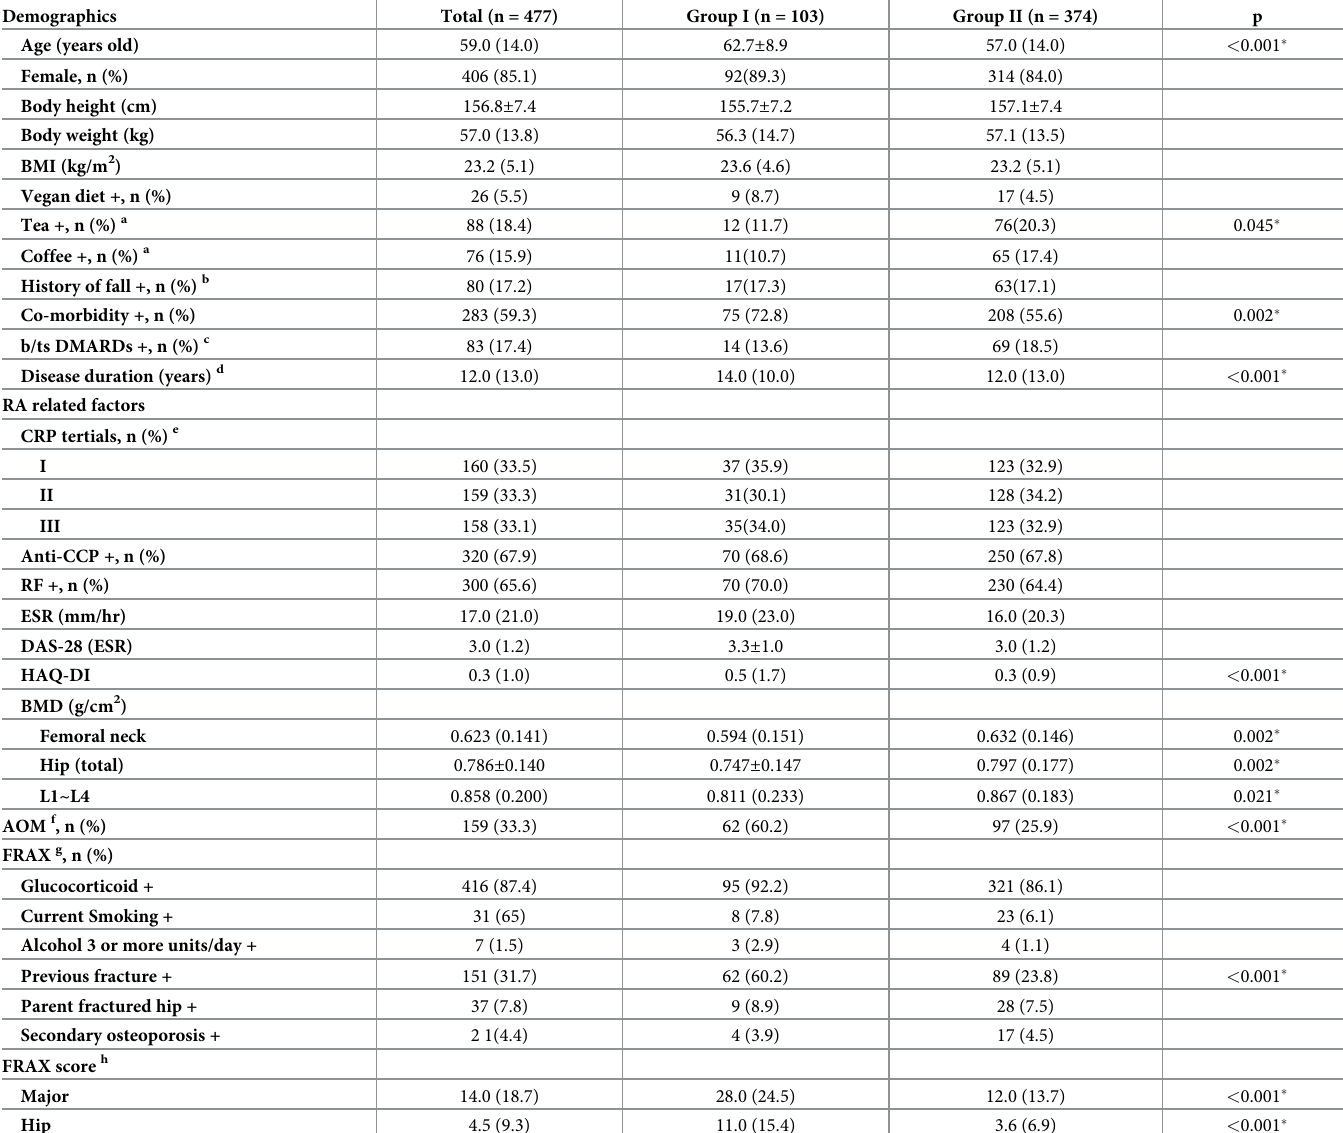
Table 1. Demographics and clinical characteristics of participants before